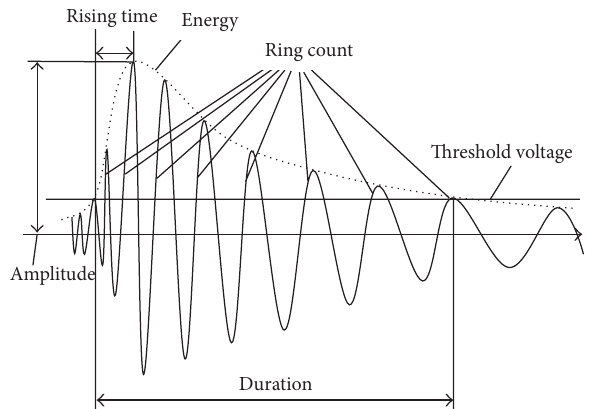
Figure3:DefinitionofsimplifiedwaveformparametersofAEsignal